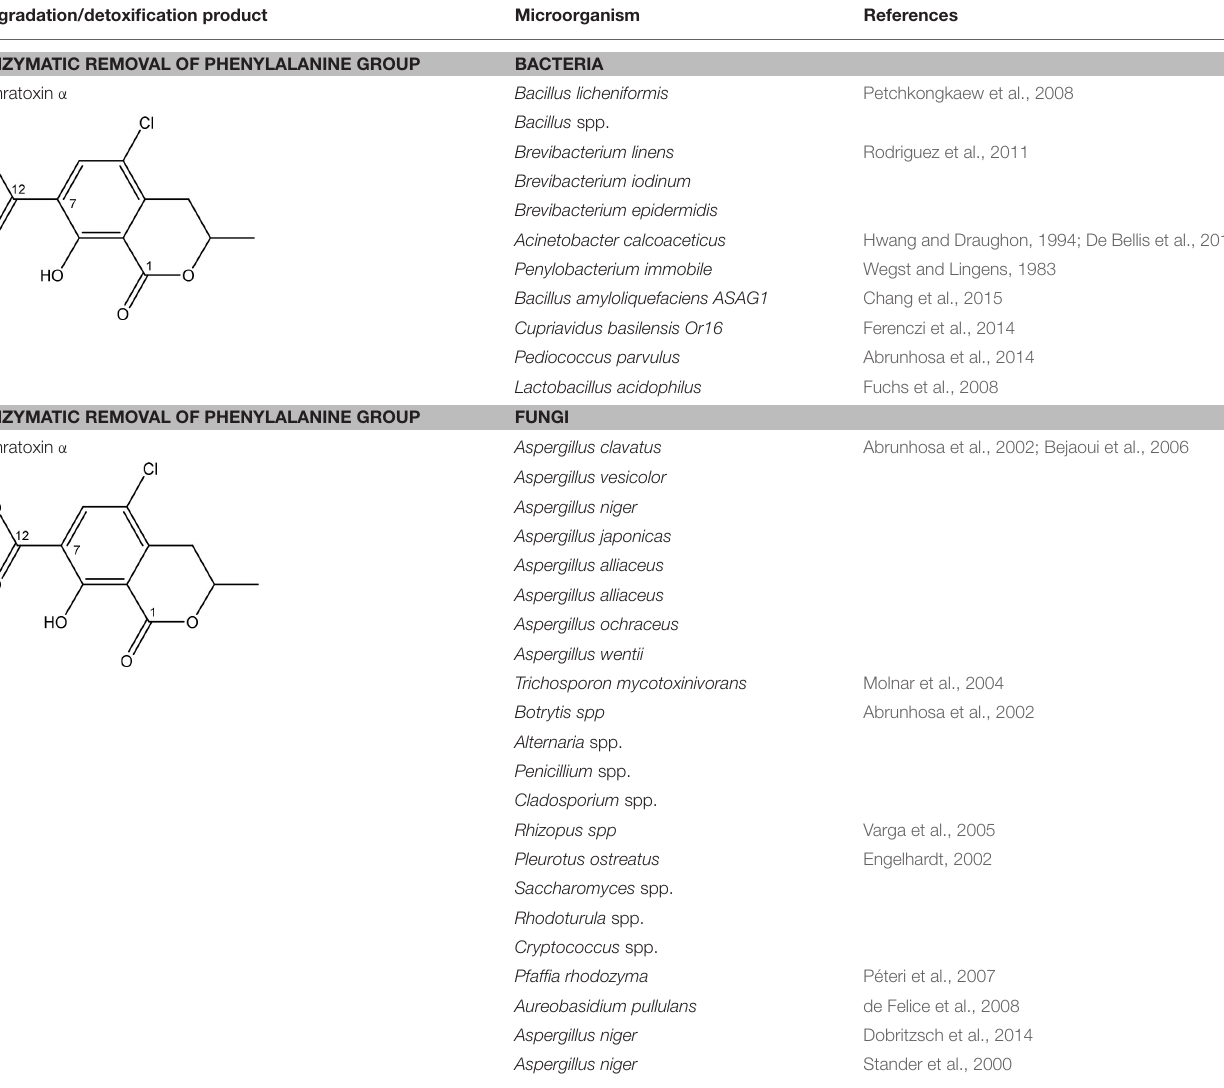
TABLE 7 | Degradation and/or detoxification products of